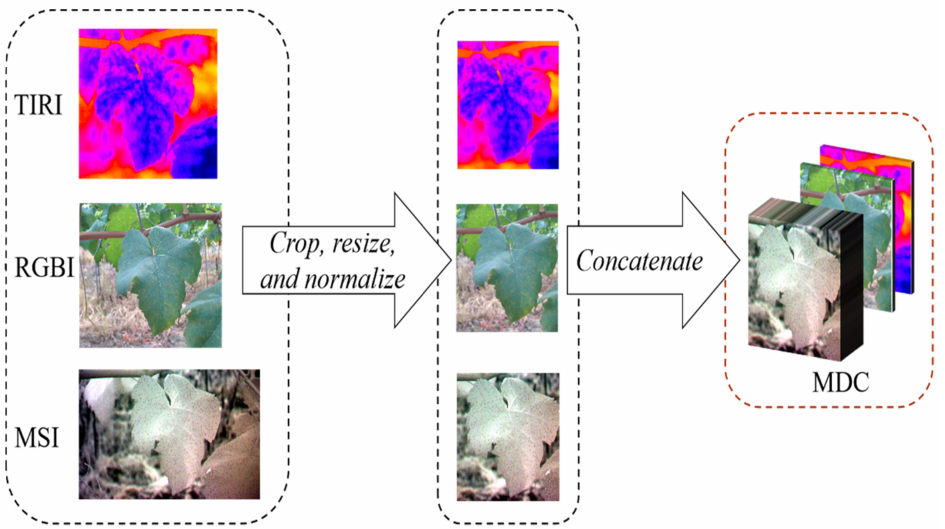
Figure 3. Data preprocessing. The sizes of RGBI, MSI, and TIRI are changed to 192 × 192 through crop- ping, resizing, and normalization, and then concatenated into the multi-source data concatenation (MDC) set, according to the sequence of MSI, RGBI, and